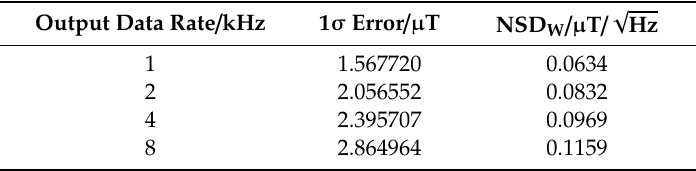
Table 7. Broadband noise performance figures for the bandwidth of 10–500 Hz.